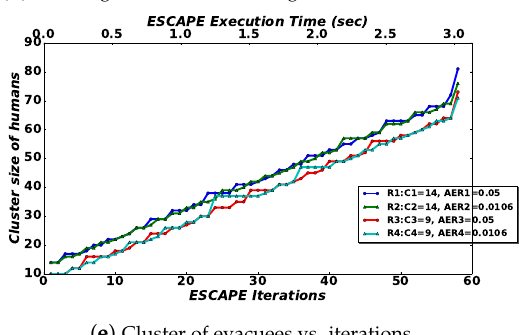
( d ) Convergence time and average reward function vs. b